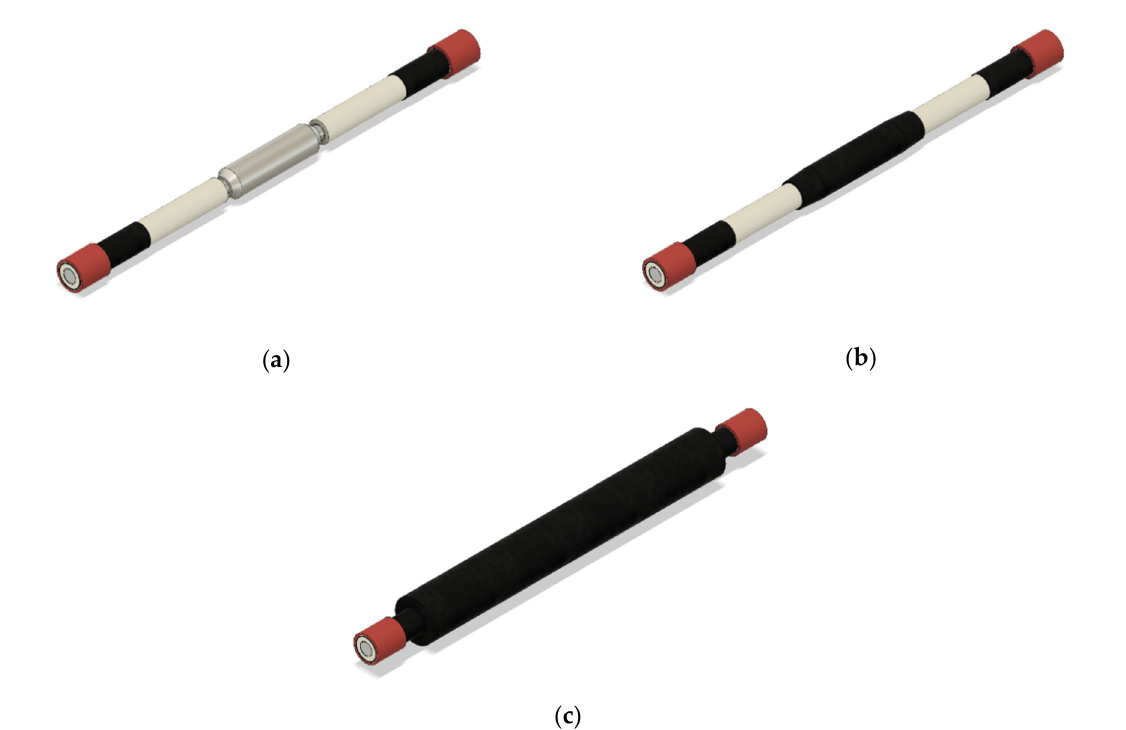
Figure 3. Joint realization steps: ( a ) metallic core; ( b ) semiconductor tape around the core; ( c ) dielectric material. A hybrid electrostatic and magnetostatic FEM model was developed with the typical physical dimensions of the joint, as shown in Figure 4.